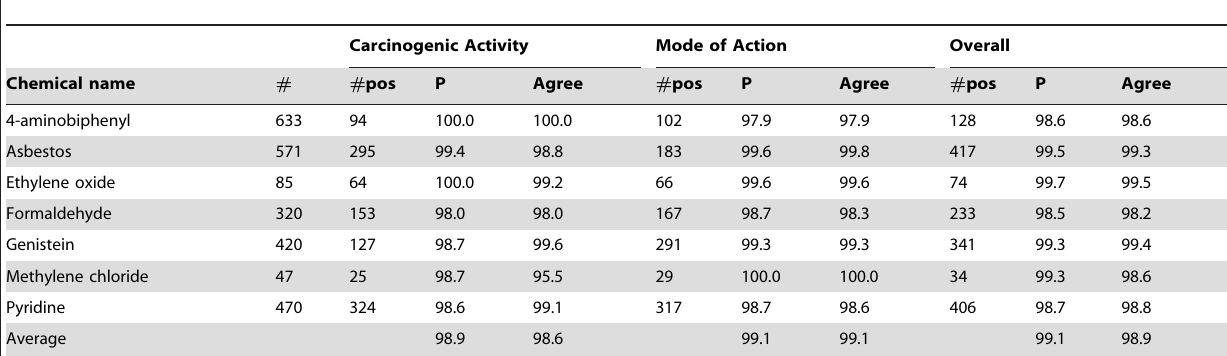
Table 2. User test results: total number of abstracts retrieved, number of abstracts classified as positive, Precision and interannotator agreement.